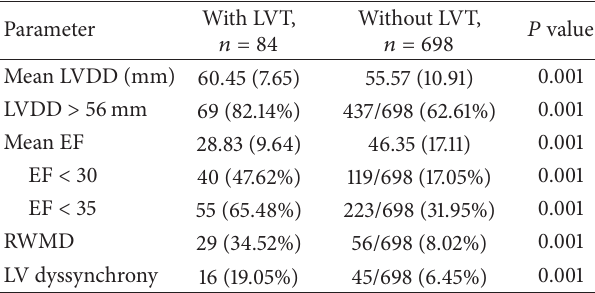
Table 1: Baseline characteristics and comparison of disorders in subjects with and without left ventricular thrombus.